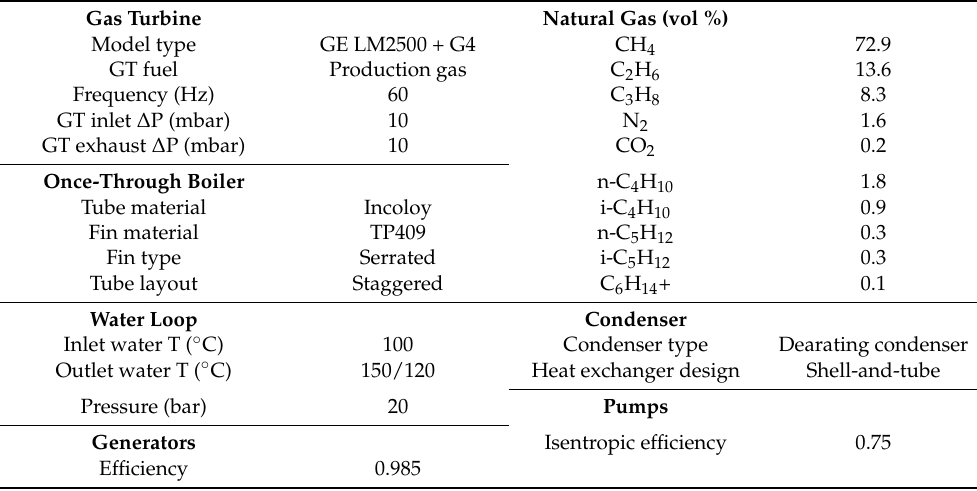
Table 1. Site conditions and modelling